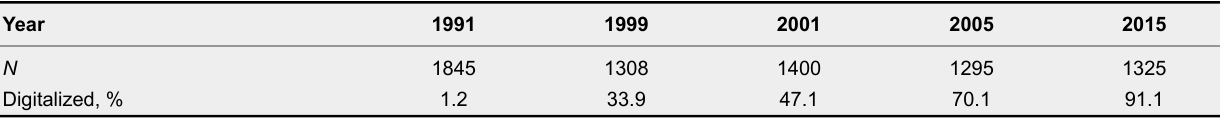
Individual Level Digitalization Among the Respondents in the 1991-2015 Period